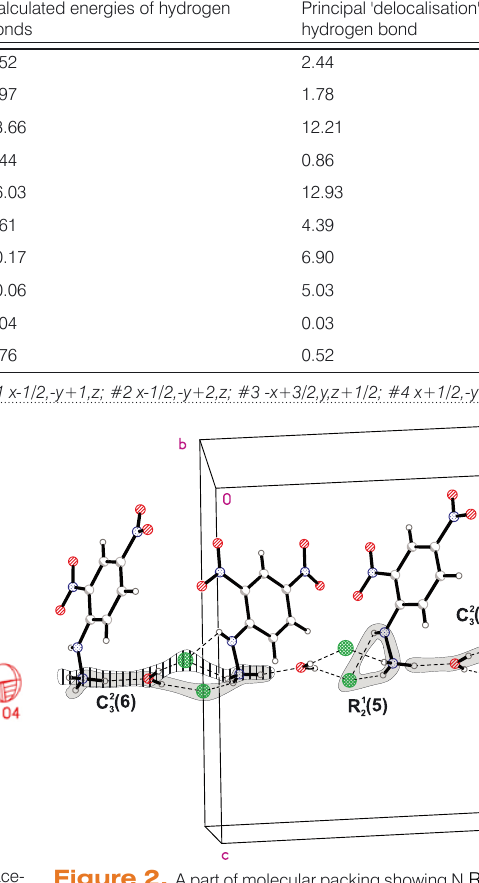
1 2 R (5), N 3 C (6) and 2 2 3